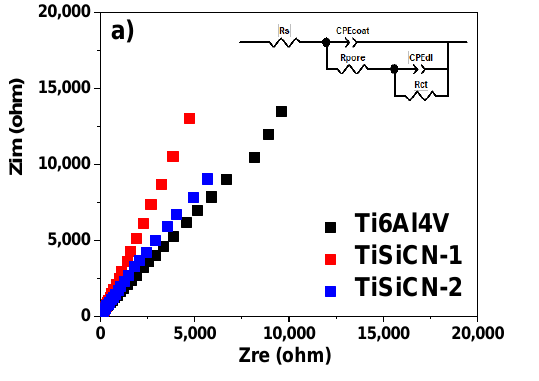
Figure 4. ( a ) Nyquist and ( b ) Bode amplitude plots for the investigated samples after 1 h immersion in 3.5% NaCl.